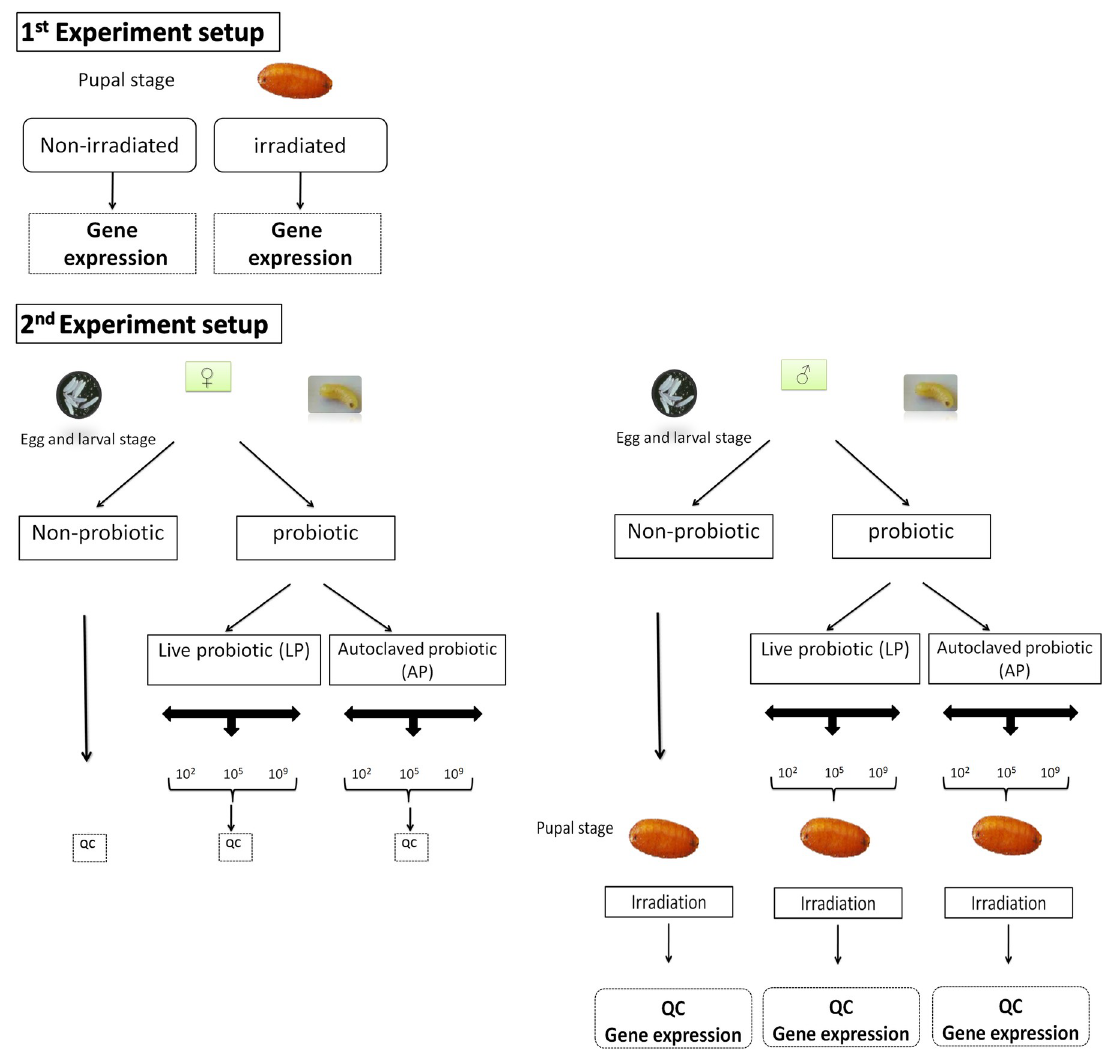
Fig 1. Summary of the experimental